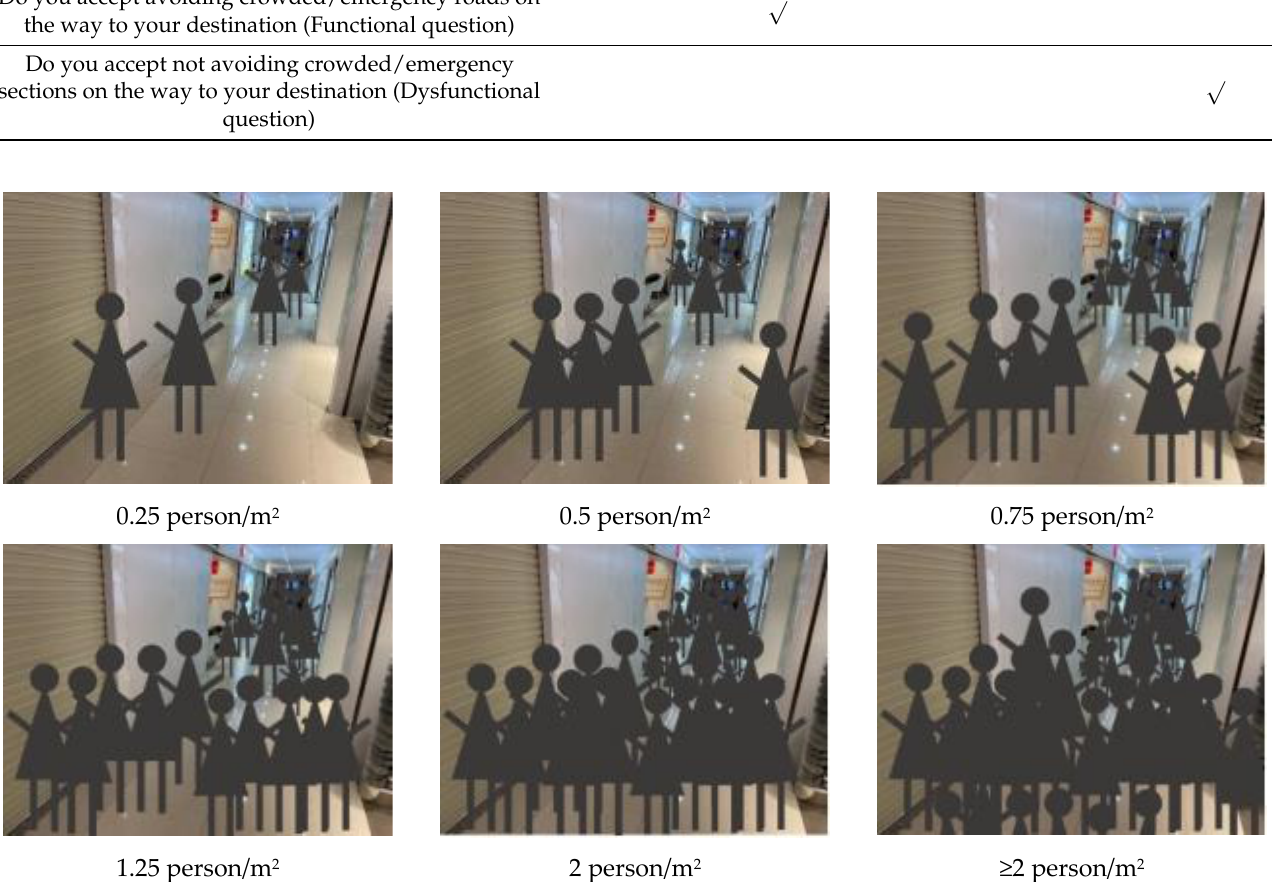
Figure 4. Pictures with the scene under different crowd densities.